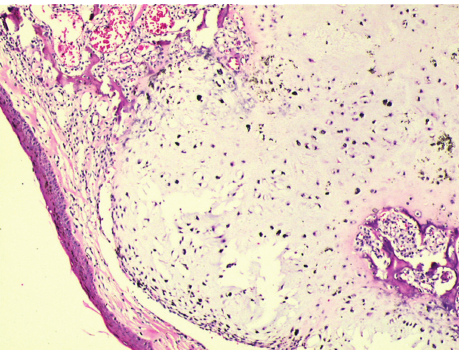
Figure 1: Lobulated tumor near the calcified normal chondroid tissue. Hematoxylen Eosin stain × 50.